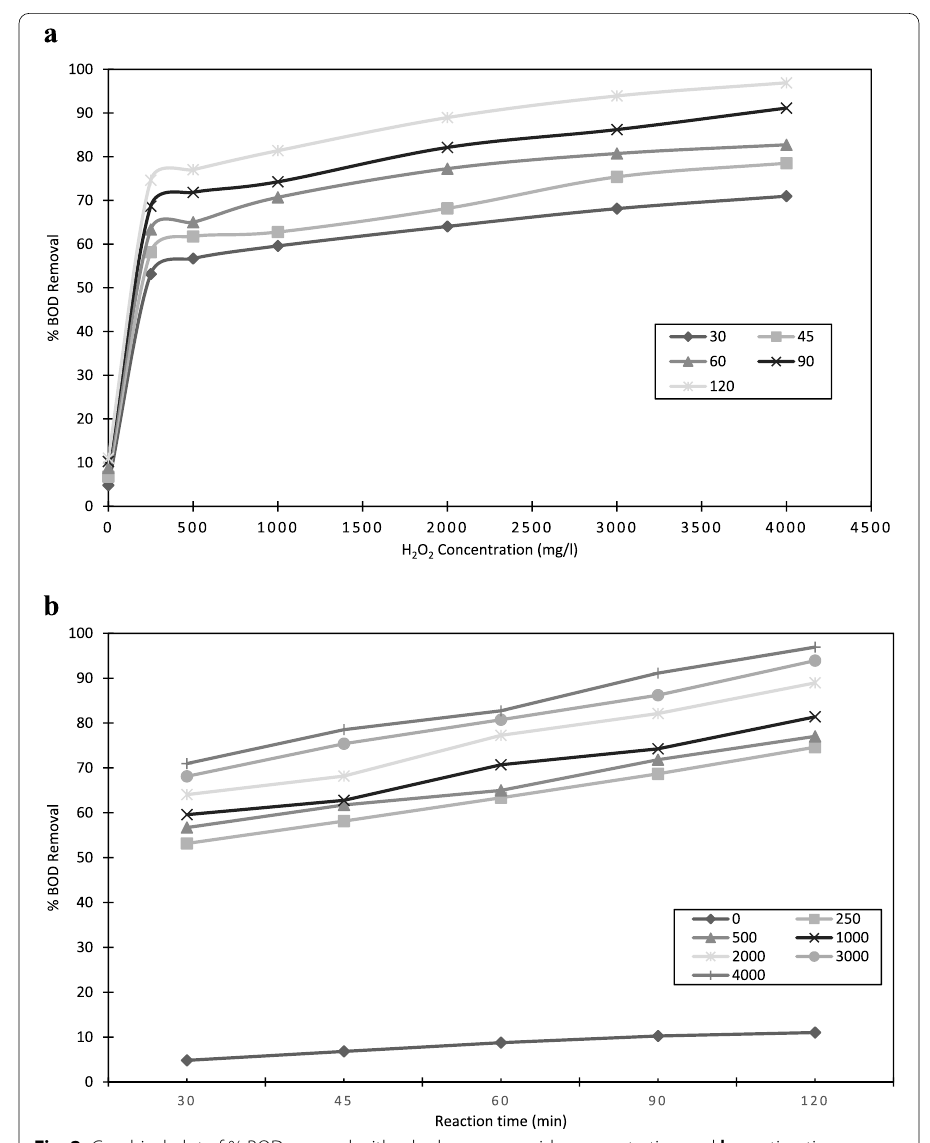
Fig. 2 Graphical plot of % BOD removal with a hydrogen peroxide concentration and b reaction